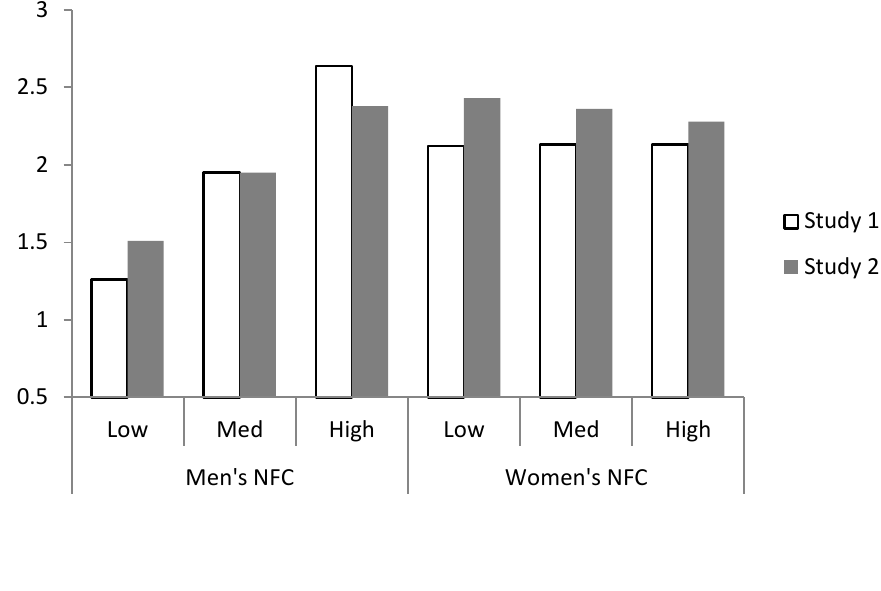
Figure 1 Impact (unstandardized beta weights) of discussion (vs. no discussion) on social engagement for men and women across levels of need for cognition